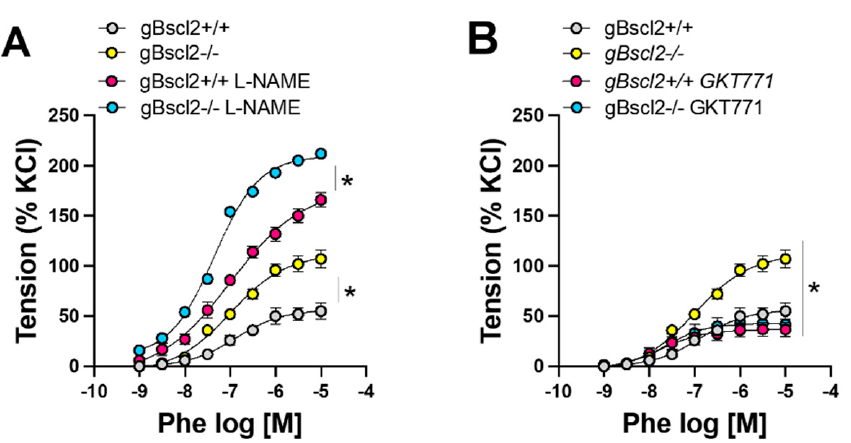
Figure 3. Lipodystrophy-associated increases in vascular adrenergic contractility are eNOS-inde- pendent but Nox1-mediated. Concentration response curves to phenylephrine in aortic rings from wild-type (gBscl2 +/+ ) or Bscl2 deficient mice (gBscl2 -/- ) in the presence of N-nitro-l-arginine methyl ester [L-NAME; (100 μ mol/L)] ( A ) or GKT771 (10 μ mol/L)] ( B ). Data are presented as mean ± S.E.M. N = 3–6. * P < 0.05 vs. gBscl2 -/- . P < 0.05 gBscl2+/+ vs gBscl2-/- in presence of L-NAME.